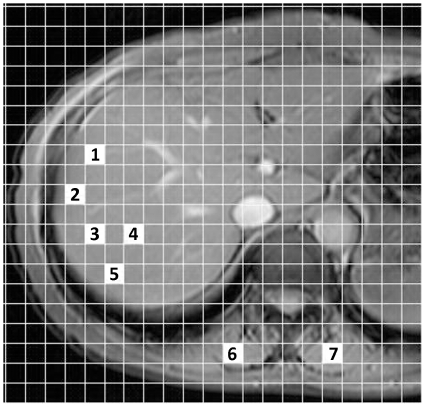
Illustration of the method used to measure regions of interest on an MR image.With use of computer software (developed in-house by the authors), two independent observers freely and easily selected a region of interest by clicking a mesh unit on the right hepatic lobe of an image while avoiding the large vessels, focal hepatic lesions, or artifacts. Seven regions of interest were chosen for liver parenchyma (1–5, total liver ROI area sampled, 500 mm2) and paraspinous muscles (6 and 7, total muscle ROI area sampled, 200 mm2) in the same slice section of each sequence.